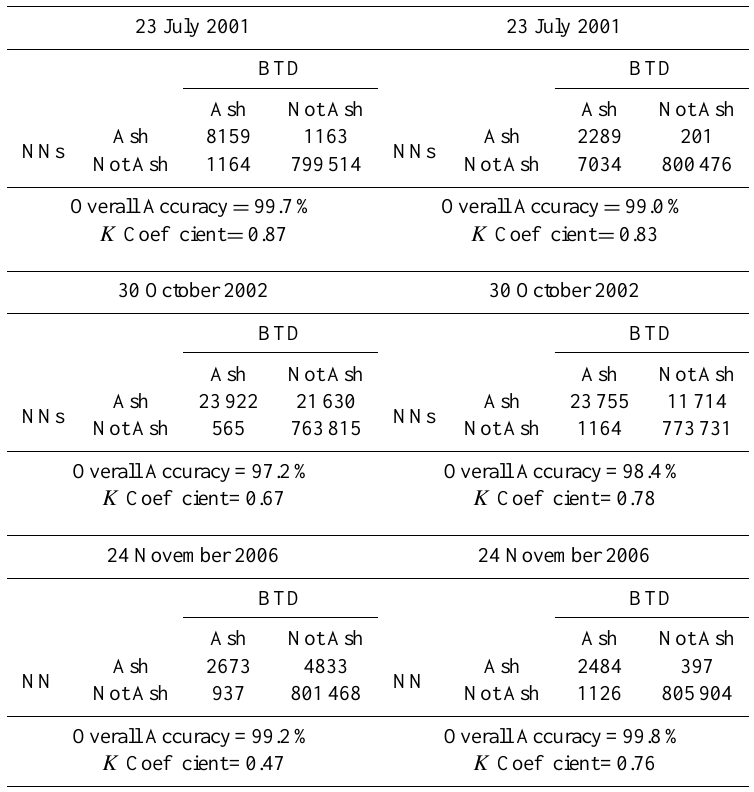
Table 3. Confusion Matrix assess the classification accuracy on the validation sets: Left column results of NN. Right column results of NN and segmentation post processing.